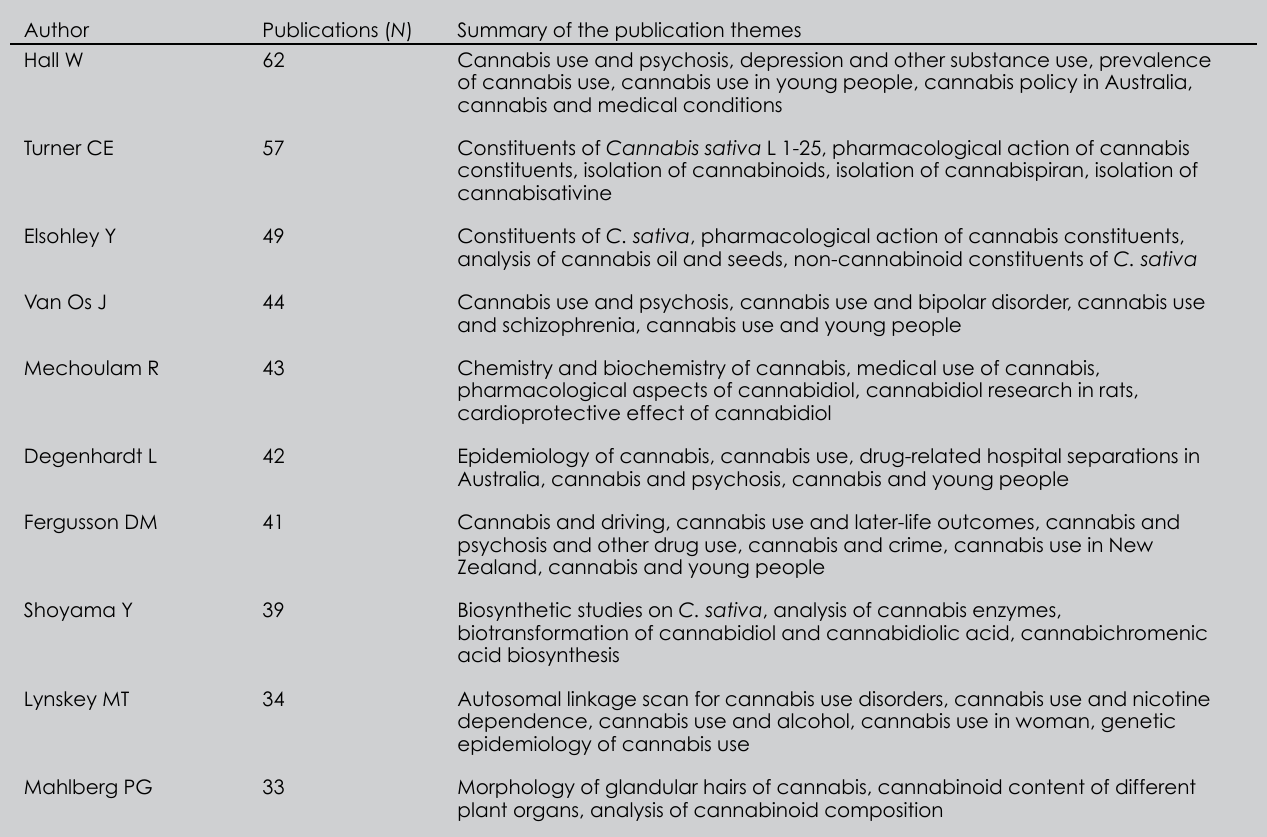
Table II. The 10 authors who published most papers on cannabis, 1900 - 2008, and a summary of the main topics of each